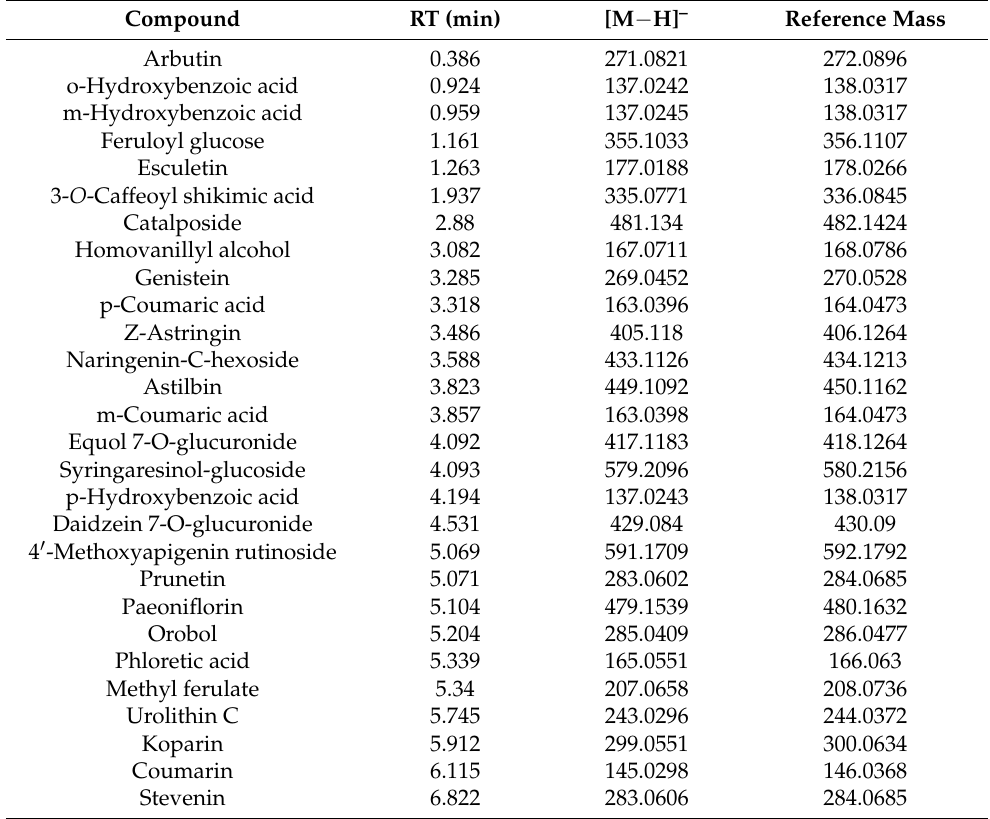
Table 1. Phenolic profile of aqueous fraction of B.